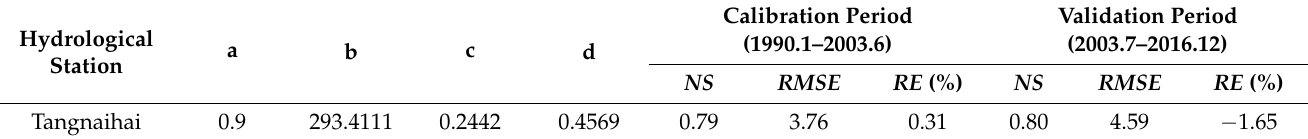
Table 3. Monthly runoff simulation results in the post-change period using the monthly ABCD model. Hydrological